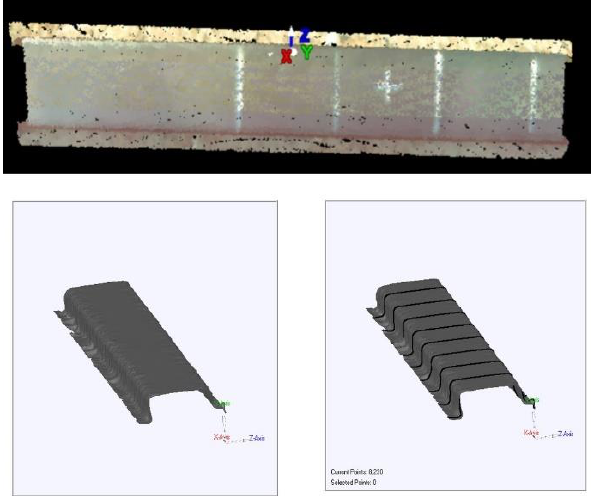
Figure 7. Point Cloud aligned in Cyclone and 3D model with section in Geomagic